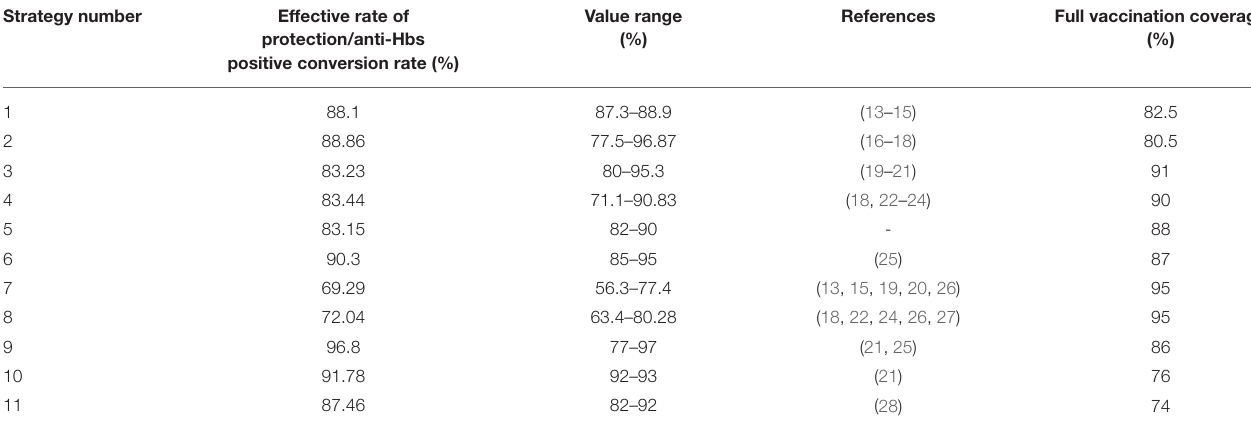
TABLE 2 | ERP/PCR of anti-HBs and FVC for 11 immunization strategies. Strategy